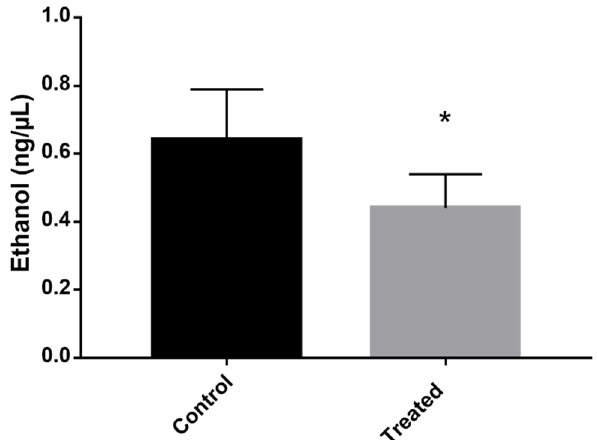
Figure 7. Evaluation of the concentration of ethanol produced by cells exposed to mebendazole. The production of ethanol in the cells was verified by quantifying it in the medium containing cells exposed (treated) or not exposed (control) to mebendazole for 12 h. The * indicates a significant difference between the control and treated samples, with a p value ≤ 0.05. The error bar represents the deviation between the biological triplicates.